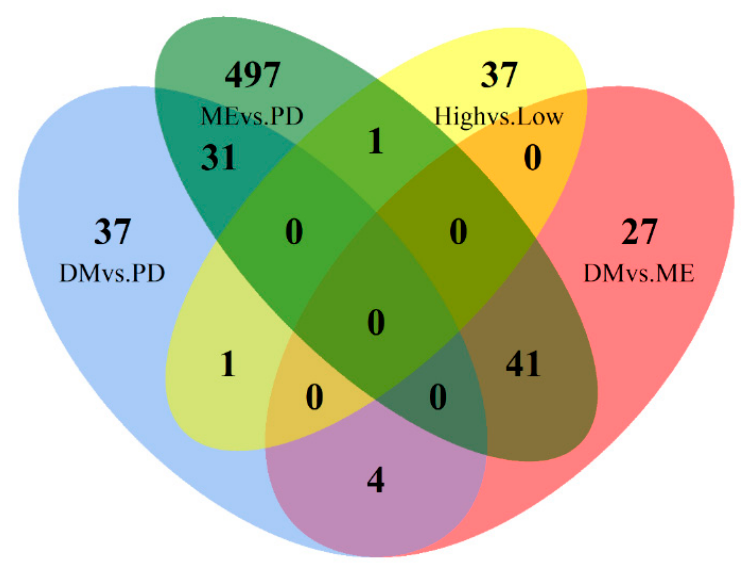
Figure 1. Venn diagram depicting the number of differentially expressed genes (DEGs) for each breed; DM: Dohne, PD: Poll Dorset, ME: Merino.